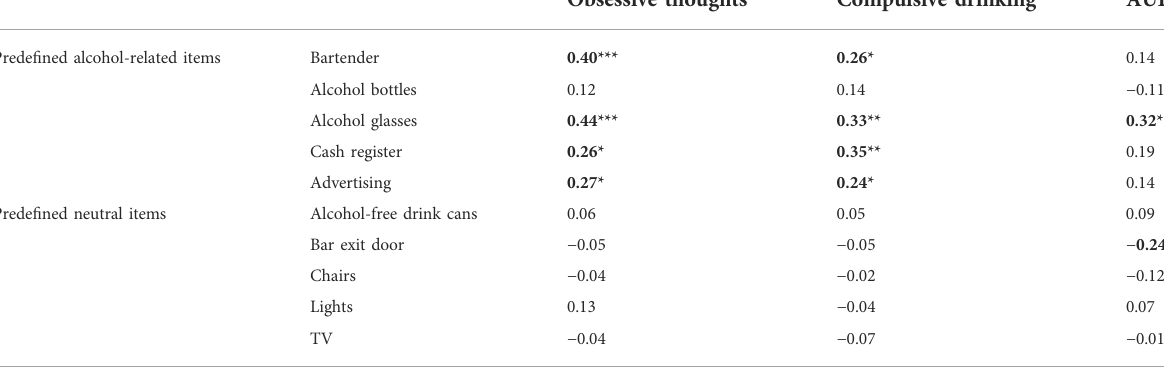
TABLE 5 Bilateral Kendall ’ s correlations between OCDS, AUDIT and the number of fi xations.